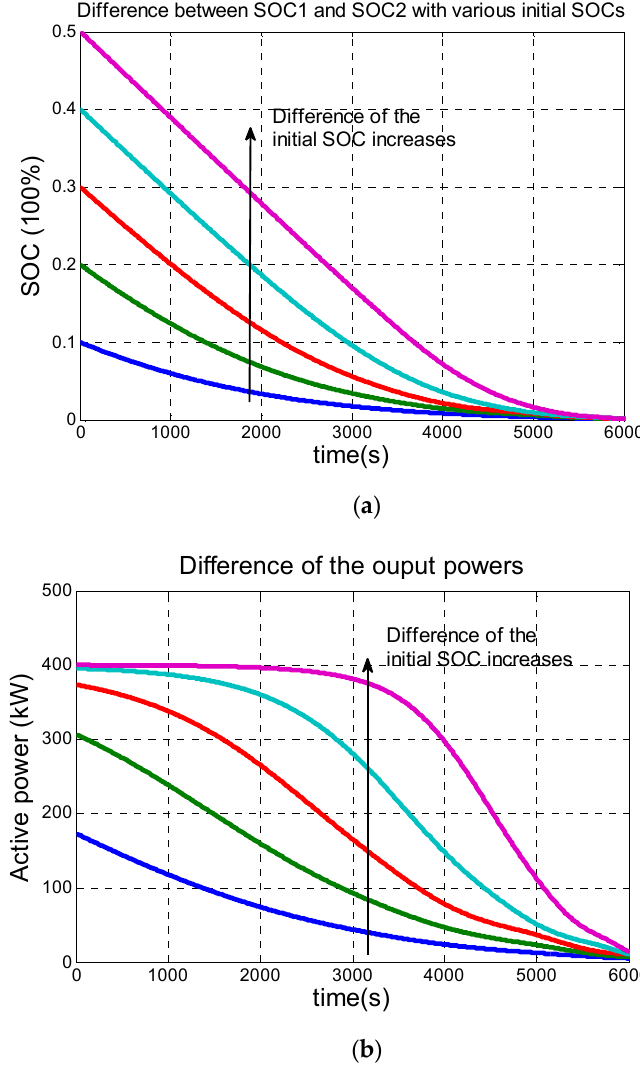
Figure 9. Waveforms of the SOC difference and output power difference with various initial SOCs. ( a ) Waveforms of the SOC difference and ( b ) output power difference.